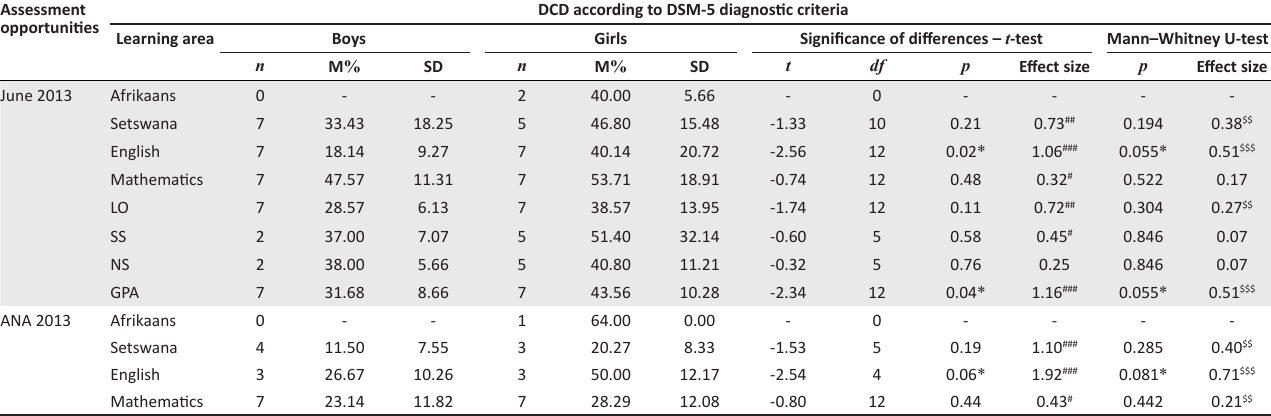
TABLE 6: Gender differences in academic achievement of learners with developmental coordination disorder according to the Diagnostic and Statistical Manual of Mental Disorders, fifth edition diagnostic criteria. Assessment opportunities